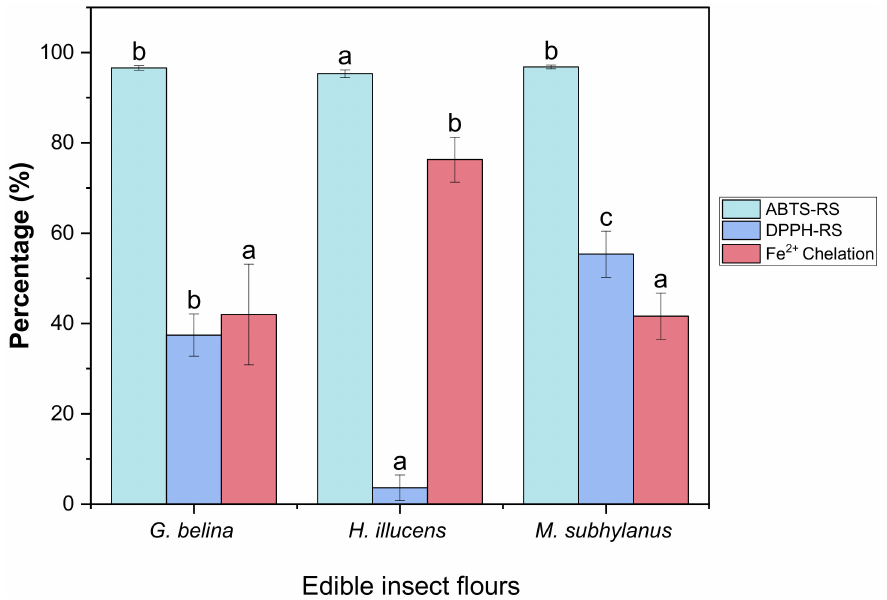
Figure 3. Scavenging effect of DPPH-RS, ABTS-RS and Fe 2+ chelating activity of edible insect flours. Values are mean ± standard deviation; means with different superscripts are significantly different ( p <